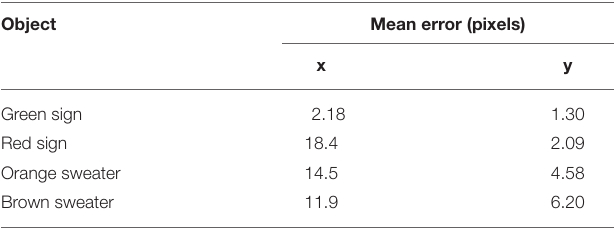
TABLE 1 | The mean error between the estimated position and the ground truth is evaluated for each tracked object in the outdoor scenes. Object Mean error (pixels) x y Green sign 2.18 1.30 Red sign 18.4 Orange sweater 14.5 Brown sweater 11.9